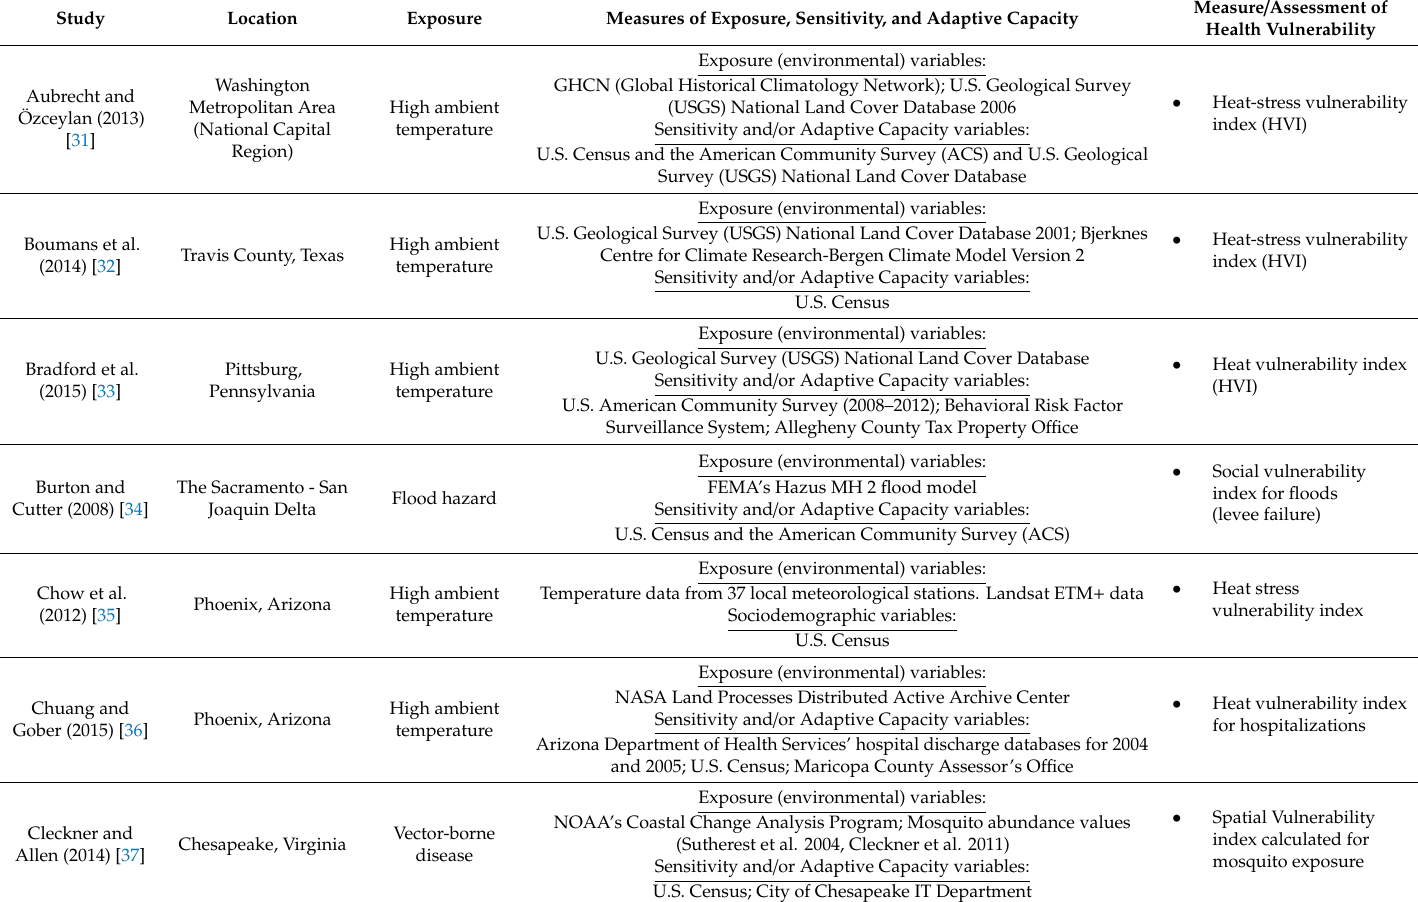
Table 1. Characteristics of studies examining vulnerability mapping of human health to climate